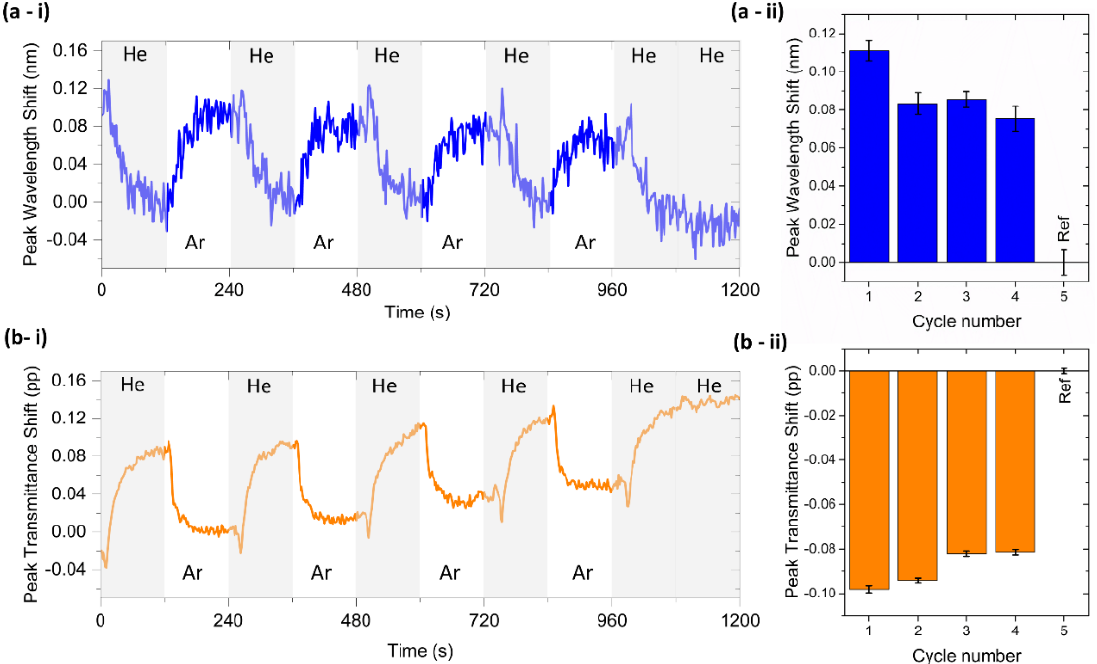
Figure 6. T-LSPR peak position monitoring of chitosan (0.5%)/Au-NPs for He and Ar cycles. Wavelength and transmittance coordinates shift of the T-LSPR peak over time ( a-i and b-i , respectively) and for 5 cycles ( a-ii and b-ii , respectively).